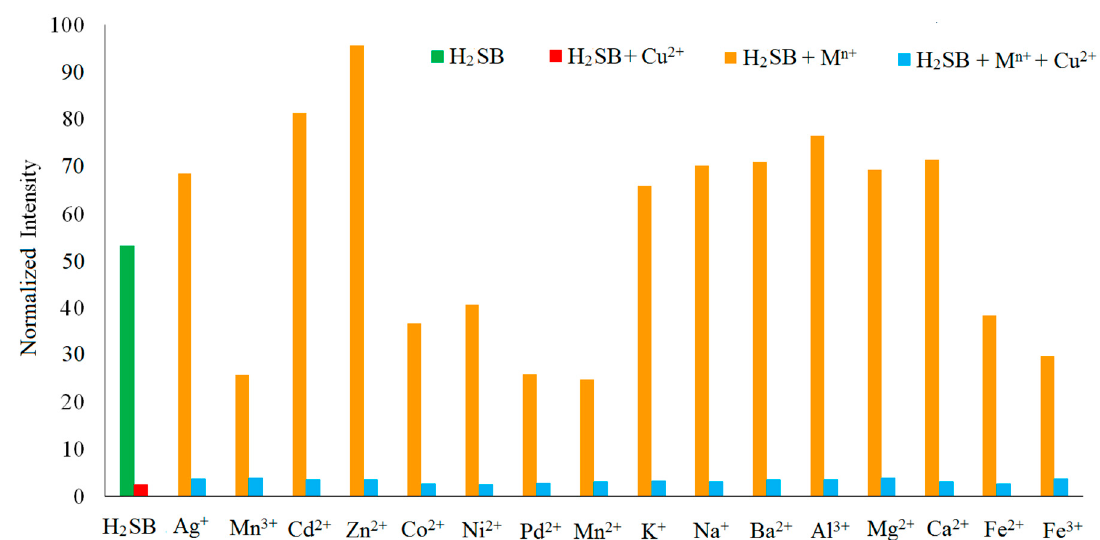
Figure 8. Fluorescence responses of H 2 SB (1.0 mL, 100 µ M) toward Cu 2 + (1.0 mL, 100 µ M) in the presence of various metal ions (1.0 mL, 100 µ M). Fluorescence intensity data have been rescaled to have values between 0 and 100. All experiments were performed in methanol-water in 80:20 v / v (pH 7.0–7.5) under λ exc = 390 nm.